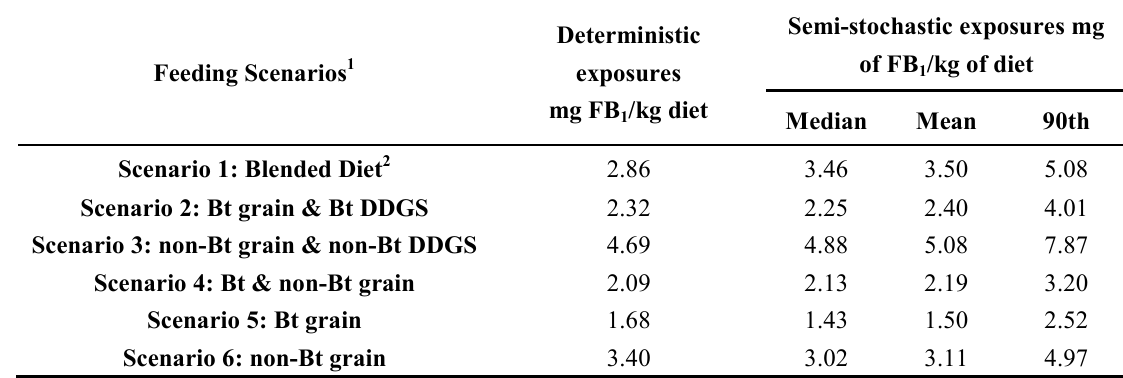
Table 5. Deterministic and semi-stochastic predictions of grower-finishing pig exposure to fumonisin B (FB ) in diets. 1 1 Feeding Scenarios 1